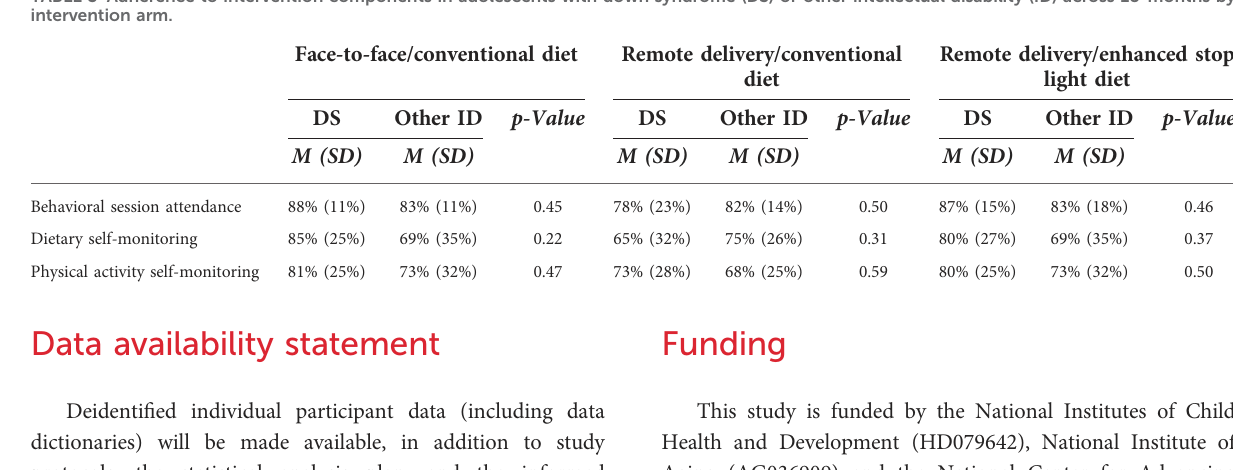
TABLE 3 Adherence to intervention components in adolescents with down syndrome (DS) or other intellectual disability (ID) across 18-months by intervention arm. Face-to-face/conventional diet